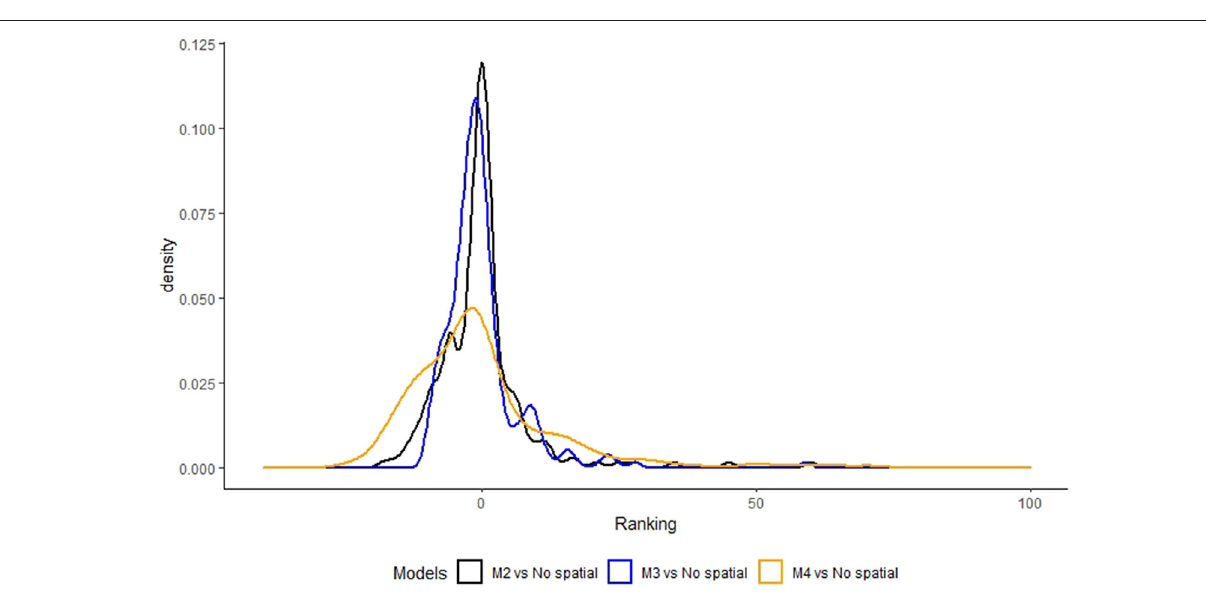
FIGURE 11 | Technical efficiency ranking differences of models 2–4 compared to Model 1 for rainfed